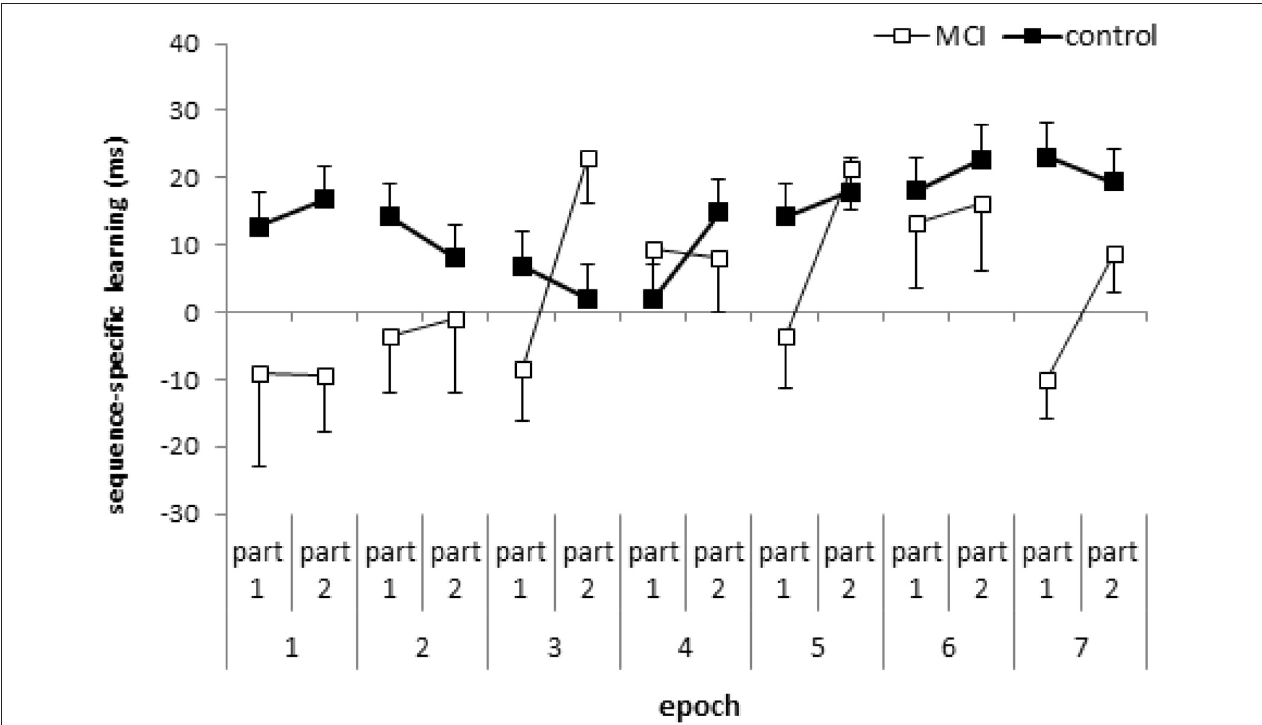
FIGURE 2 | Sequence-specific learning (measured by the RTs for the low- minus high-frequency triplets) in the first and second parts of the blocks, collapsed into epochs, is plotted for the MCI and control group. Error bars indicate standard error of mean.